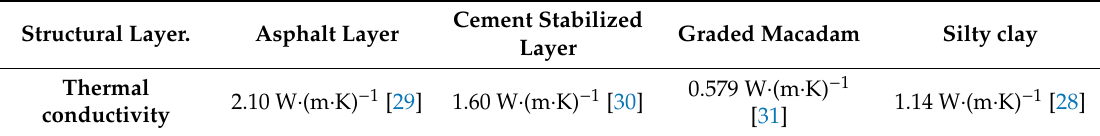
Table 2. Thermal conductivity of the road structure layers.